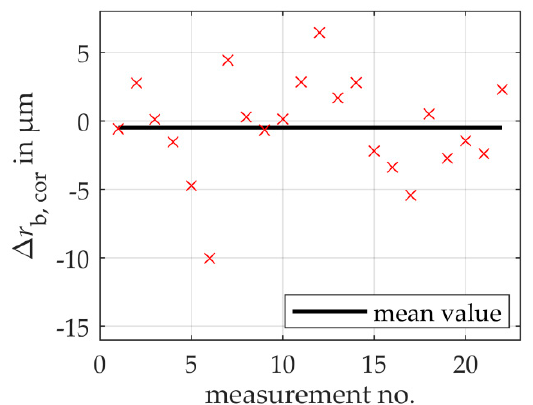
Figure 6. Experimental results of the remaining deviations of the determined mean base circle radii to the corresponding reference base circle radii for repeated measurements on the measured gear. On average, no significant systemic error is found.